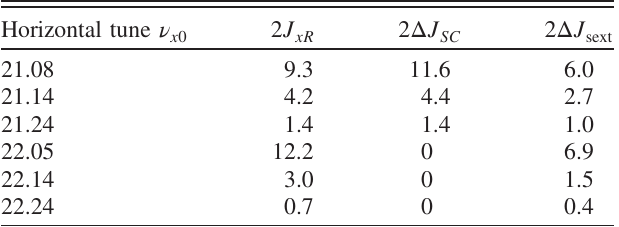
TABLE IV. The on-resonance action 2 J xR and the resonance widths calculated analytically. The units of 2 J xR , 2 Δ J SC , and 2 Δ J are μ m. sext